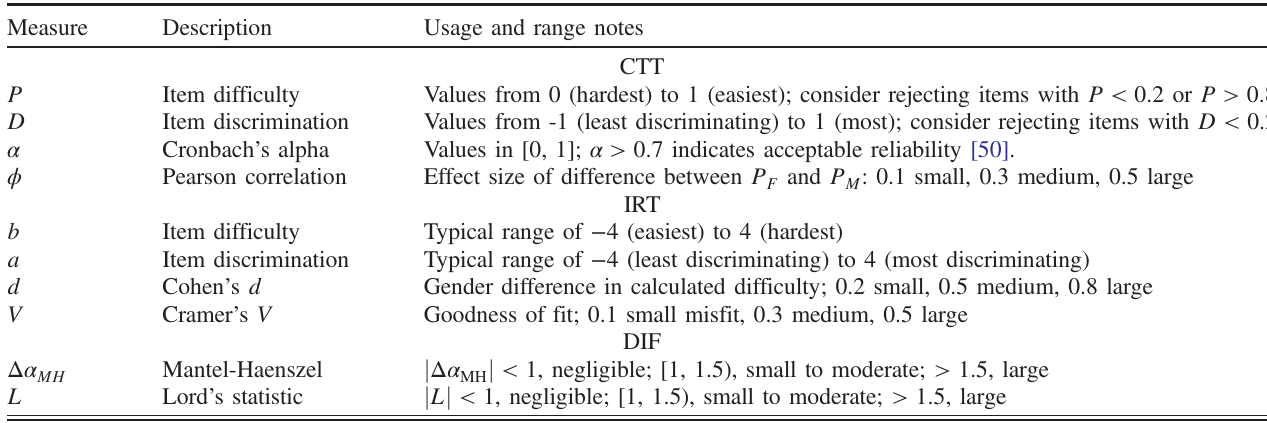
TABLE I. Summary of item statistics, goodness-of-fit measures, and effect sizes reported in this study. Measure Description Usage and range